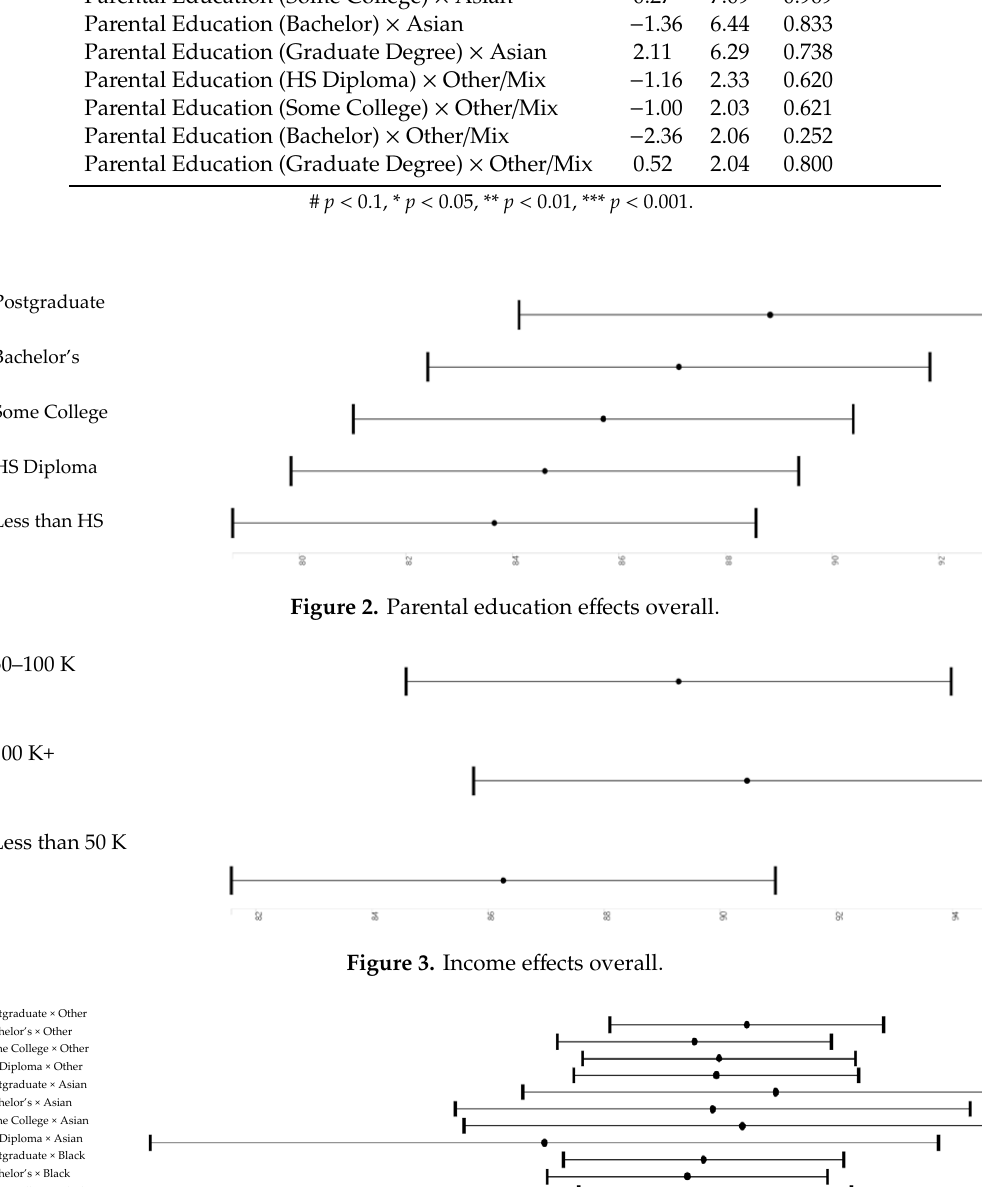
Figure 3. Income effects overall.